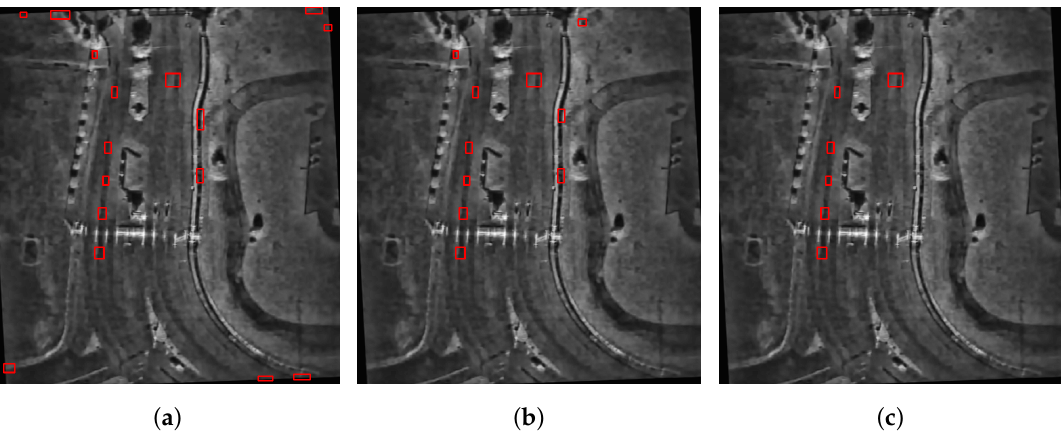
Figure 7. False alarm reduction results of the 18th frame. ( a ) Description of pre-detection result. ( b ) Description of false alarm reduction result via unweighted edge detection. ( c ) Description of false alarm reduction result via gradient-weighted edge detection. Red blocks represent detected objects.